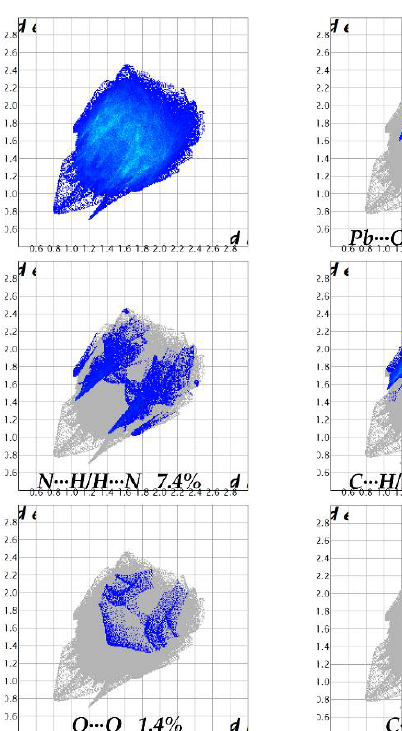
Figure 9. Full and decomposed fingerprint plots corresponding to various contacts involved within the structure of compound ( 1 ).